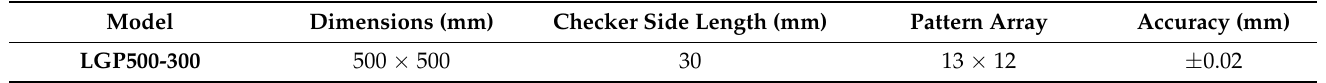
Table 1. Alumina calibration plate parameters.